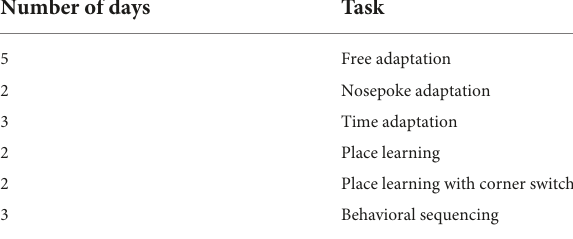
TABLE 1 IntelliCage programs timeline